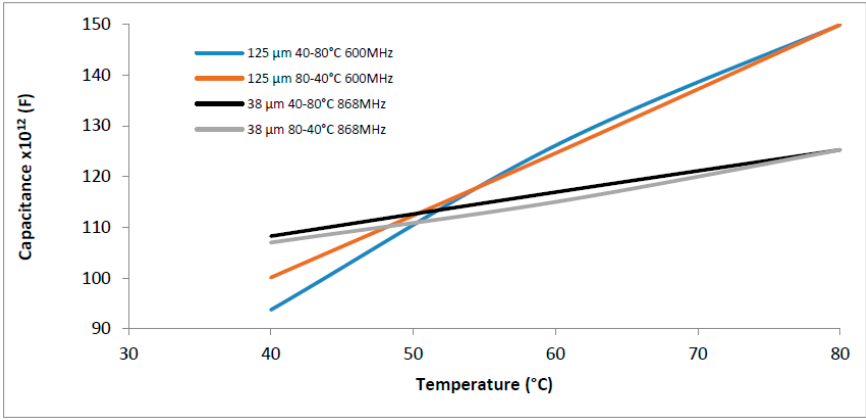
Figure 5. Hysteresis of gelatin from 40 °C to 80 °C and 90% RH for two thicknesses: 125 µm (600 MHz)